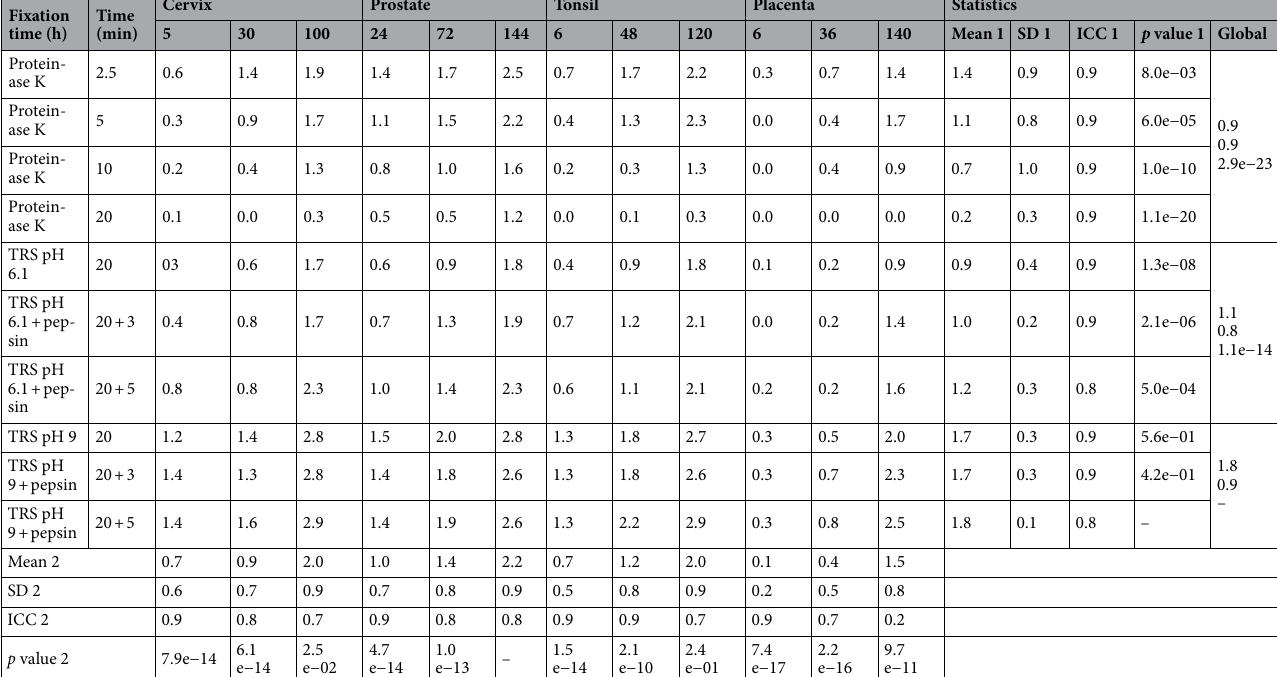
Table 1. MicroRNA in situ hybridization, ISH, result table. The means of all three ISH experiments with the miR-205-5p, miR-145-5p and miR-126-3p probes, due to the given parameters, are presented within the largest square (main table). The upper horizontal bar shows the included tissue, and the numbers indicates the period of formalin fixation in hours. The first column from the left indicates pretreatment for permeabilization: proteinase K or Heat-induced microRNA Retrieval (target retrieval solution (TRS) pH 6.1 or TRS pH 9) with (w/) or without (w/o) pepsin addition. The second column shows exposure time for the given treatment. The additional number after the (+) presents enzymatic treatment w/ pepsin in minutes (min). The five columns to the right and four rows below the main table display statistics for the wide and longitudinal data: each test according to the ten pretreatments, regardless of tissue type and fixation period or the twelfth tissue-fixation categories. Mean 1 and 2 presents the mean across data points for the given pretreatment or tissue-fixation category SD 1 and 2, standard deviation. ICC 1 and 2, Intraclass correlation coefficients. p value 1 and 2, pairwise Wilcoxon signed-rank test relative to the best rated, assigned as (−). Global, the statistics are